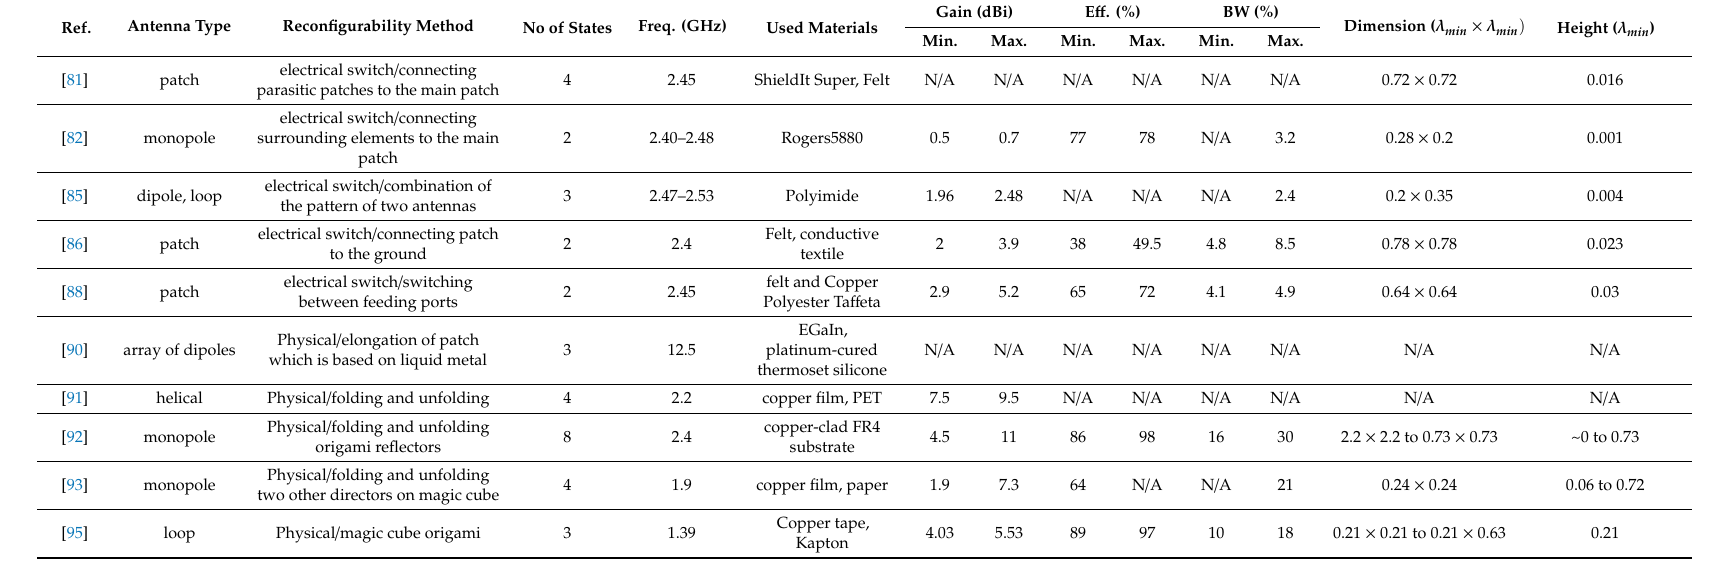
Table 2. Comparison of methods and materials used in di ff erent kinds of flexible pattern-reconfigurable antennas, along with corresponding performance.